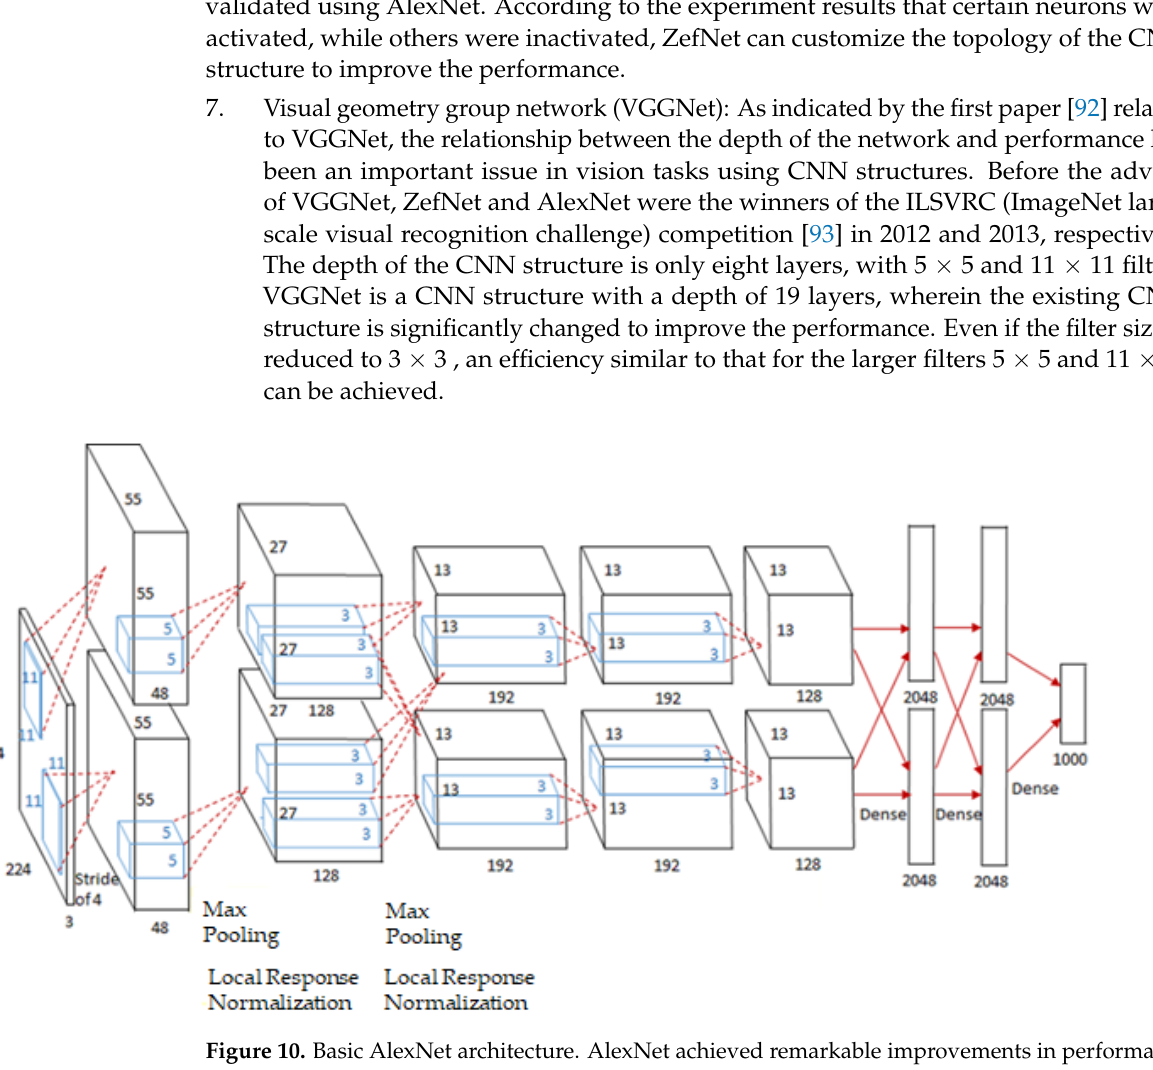
Figure 11. Basic ZefNet architecture. ZefNet can customize the topology of the CNN structure to improve the performance.